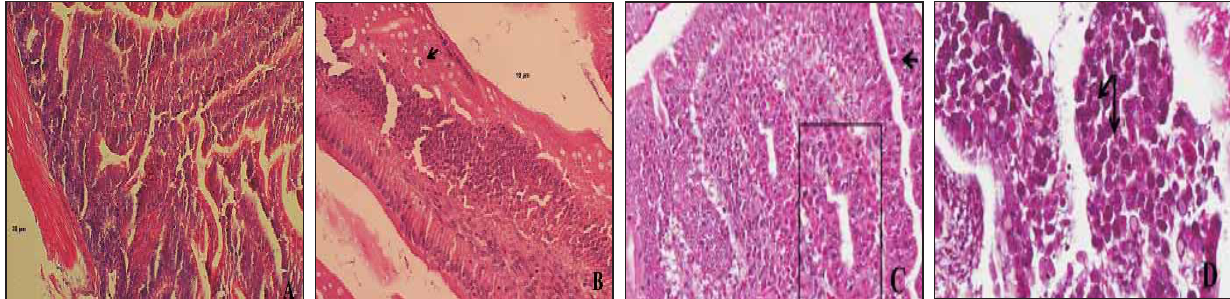
Figure-5: Jejunum sections of chicken infected with oocysts (1.0x10 sporulated oocyst/chick) showing: oocyst's developmental stages in the jejunum cells. (A) Photomicrograph of a jejunum from broiler chicken of the control. Normal jejunum can be seen. (H&E) x80; (B) Photomicrograph of a jejunum from a broiler chicken inoculated with at 96 h PI: presence of second mature schizonts in the border cells of villi. (H&E) x400; (C) Photomicrograph of a jejunum from a broiler chicken inoculated with at 120 h PI: zygotes and oocysts in the cells. (H&E) x400; (D) Photomicrograph of a jejunum from a broiler chicken inoculated with at 144 h PI: fourth generation schizonts, oocysts, zygotes, gametocytes in submucosa cells. (H&E). x400. Arrow indicates different forms of the intracellular parasite.